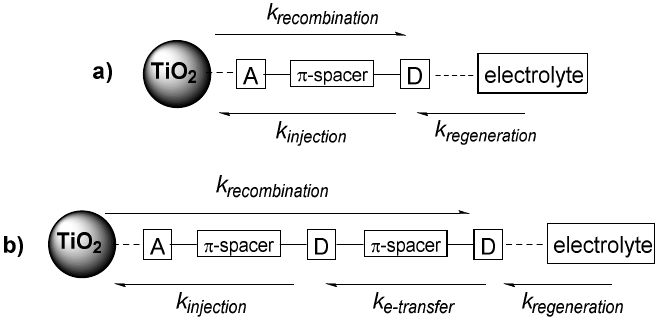
Figure 7. A simplified schematic of ( a ) traditional D-π-A dye motifs and ( b ) proposed bichromic dye kinetics.